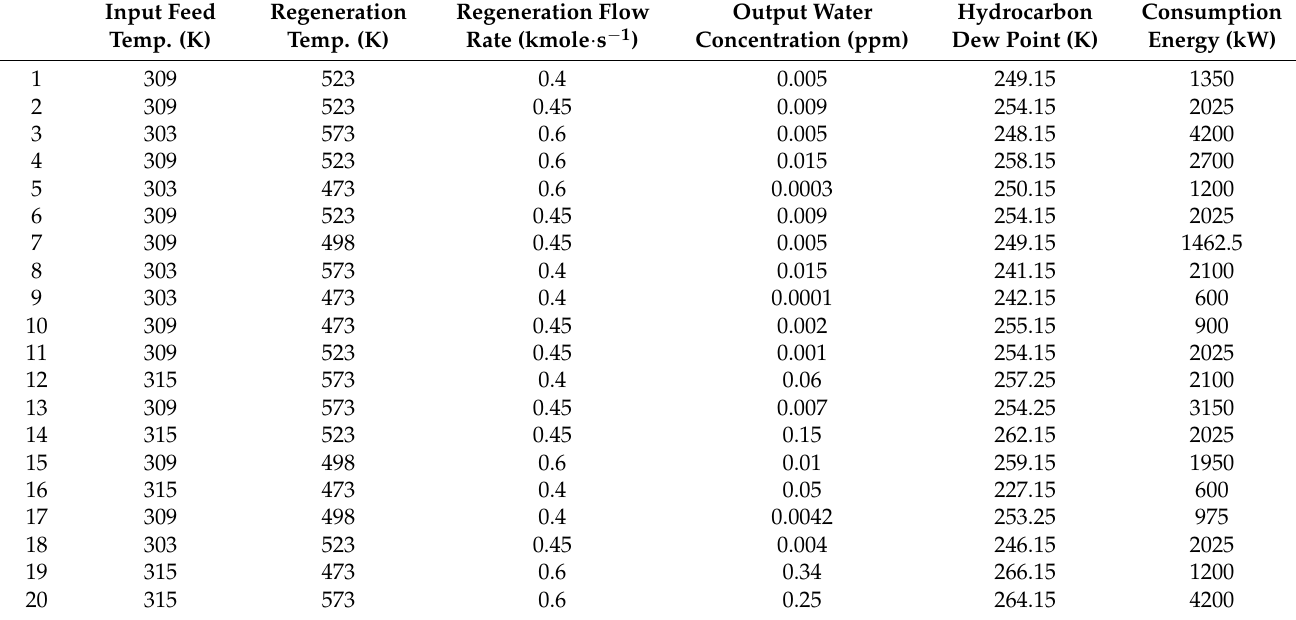
Table 7. Required data for